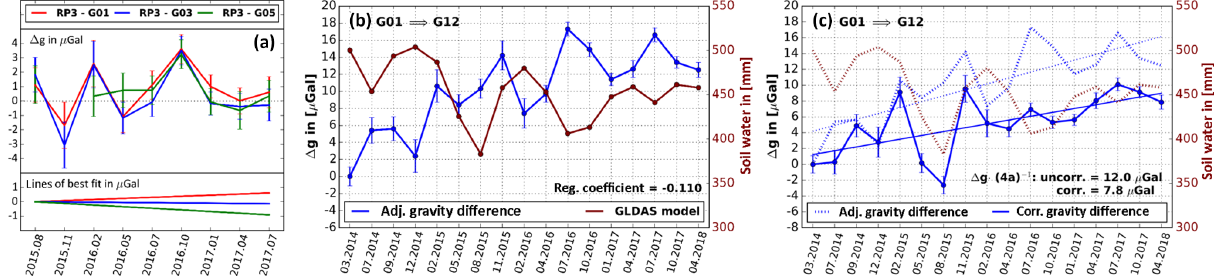
Figure 8. Results of time-lapse gravity monitoring shown by the adjusted gravity differences ( (cid:49)g ) between the stable reference point RP3 and points G01, G03, and G05, as well as, exemplarily shown, by the adjusted gravity difference between points G01 and G12 ( (cid:49)g xy = − (cid:49)g yx ). (a) (cid:49)g scatter around zero and reveal that gravity points G01, G03, and G05 are stable. In addition, the best linear fit shows an insignificant trend of < 1µGal over 2 years for the three shown (cid:49)g . The (cid:49)g values are based on the absolute gravity measurements at point RP3, carried out by Leibniz University Hanover (LUH), which prove that RP3 is stable (Ludger Timmen, LUH, personal communication, 4 December 2018). (b) (cid:49)g (blue) compared to the soil water content from GLDAS (brown) and the calculated regression coefficient between both in the dimension of µGalmm − 1 . (c) (cid:49)g (solid blue) corrected for soil water using the regression coefficient. Dotted lines show the previous state. Regression lines show the (cid:49)g over 4 years before and after the hydrological correction, as well as the decrease of the